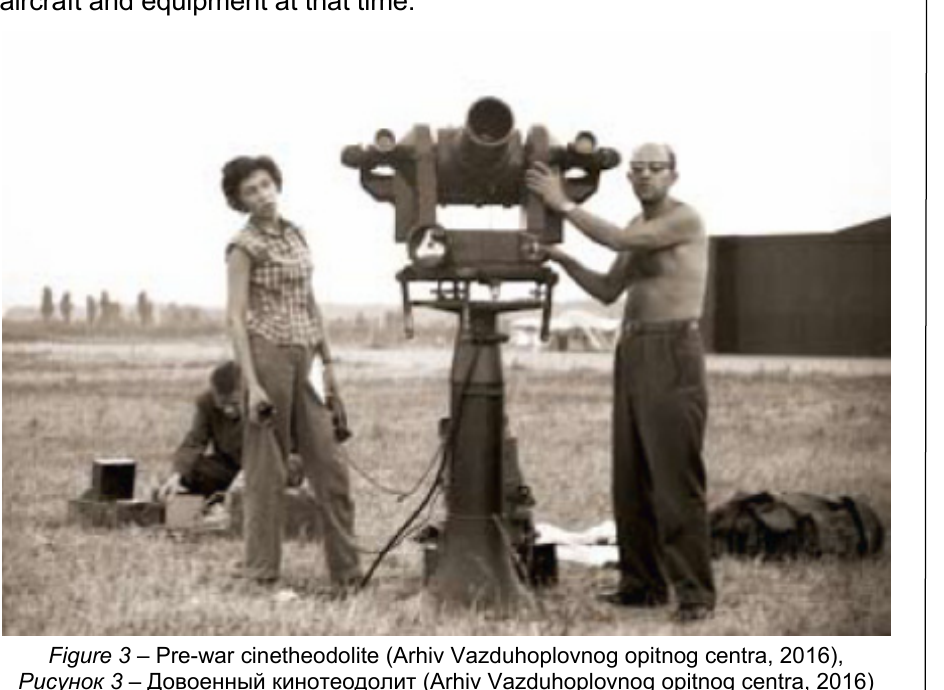
Figure 3 – Pre-war cinetheodolite (Arhiv Vazduhoplovnog opitnog centra, 2016), Рисунок 3 – Довоенный кинотеодолит (Arhiv Vazduhoplovnog opitnog centra, 2016) Слика 3 – Предратни кино теодолит (Arhiv Vazduhoplovnog opitnog centra,